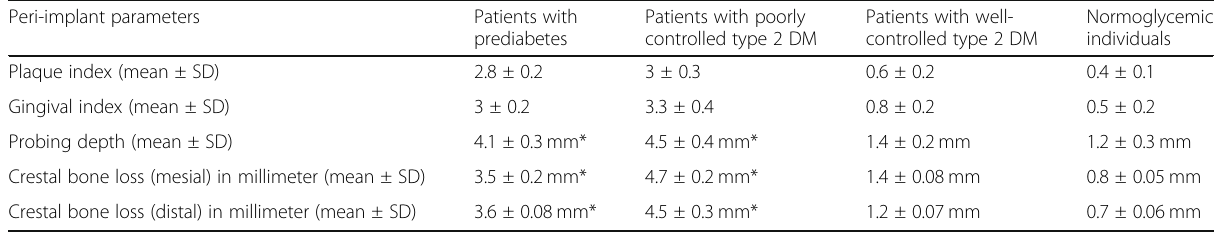
Table 3 Peri-implant gingival index, probing depth, and mesiodistal crestal bone loss among patients with prediabetes and type 2 diabetes mellitus and normoglycemic individuals